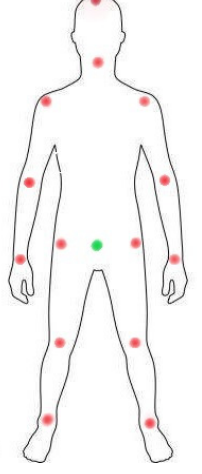
Figure 2. Schematic diagram of the location of the selected feature points (red dots are the 14 selected feature points; green dots are the anchor points of the SC).